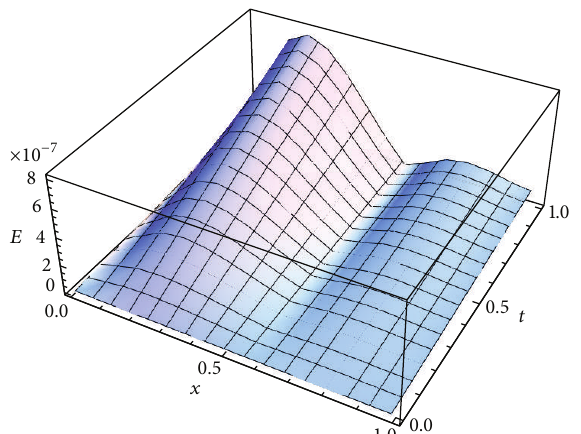
Figure 4: The approximate solution of problem (35) where 𝛼 = 0 , 𝛽 = 1 , ] = 𝜂 = 𝛾 = 10 −3 , and 𝑁 = 12 for 𝛿 = 1 .